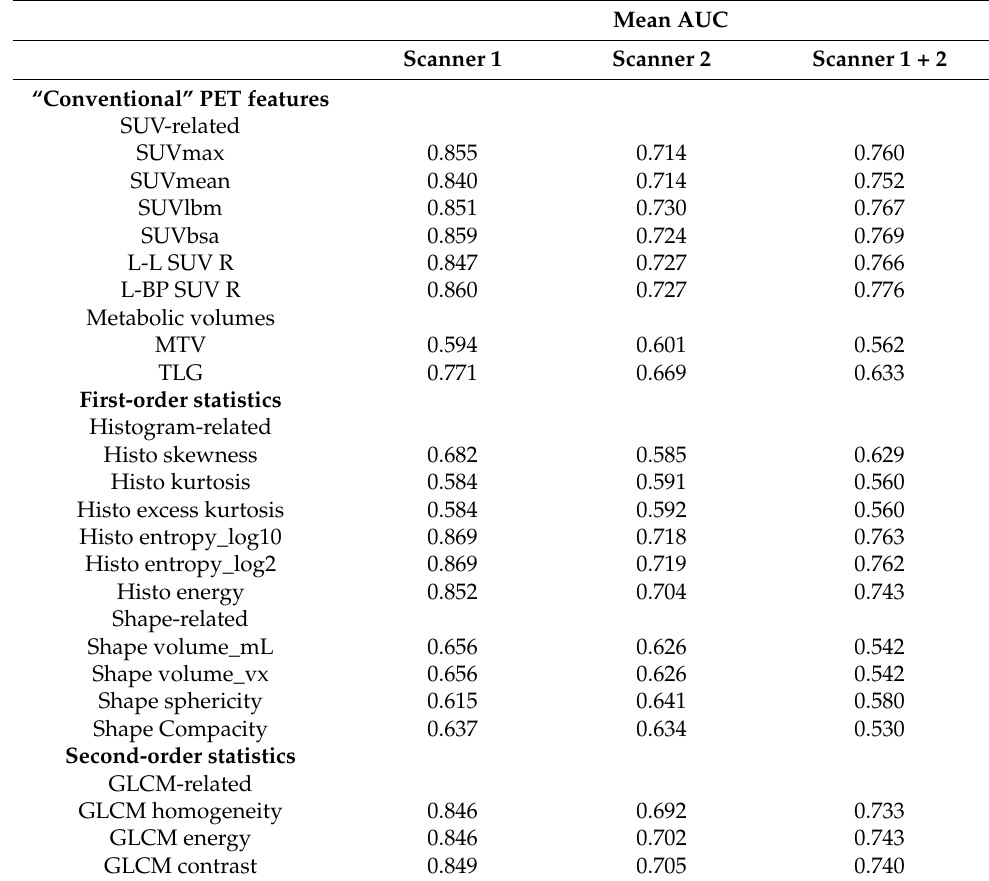
Table 4. Univariate analysis for all PET and RFs and each scanner considered alone or in